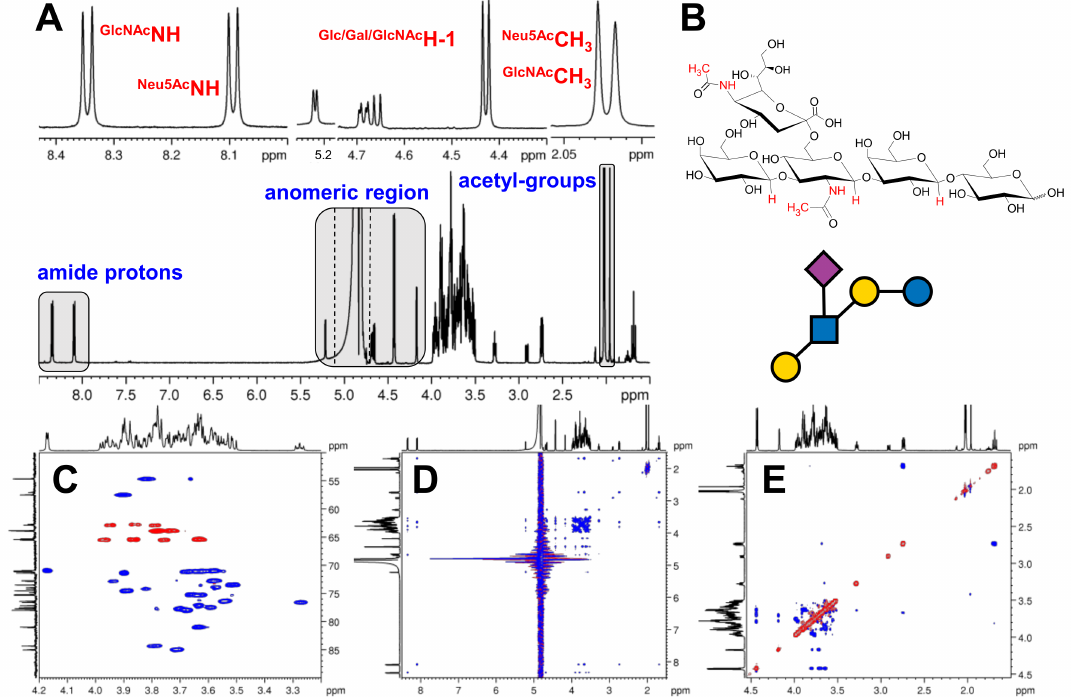
Figure 2. Representative NMR spectra of LSTb (5 mg in 600 µ L H 2 O:D 2 O (9:1) solvent using 5 mM phosphate buffer and 0.5 mM DSS reference at pH 3.0). ( A ) The 600 MHz 1 H NMR spectrum of LSTb using solvent suppression highlighted the characteristic 1 H spectral regions. ( B ) The molecular structure of LSTb. ( C ) The “carbohydrate” region of 1 H- 13 C HSQC spectrum of LSTb, ( D ) 2D 1 H- 1 H TOCSY spectrum of LSTb. ( E ) Selected 1 H- 1 H 2D ROESY spectral region of